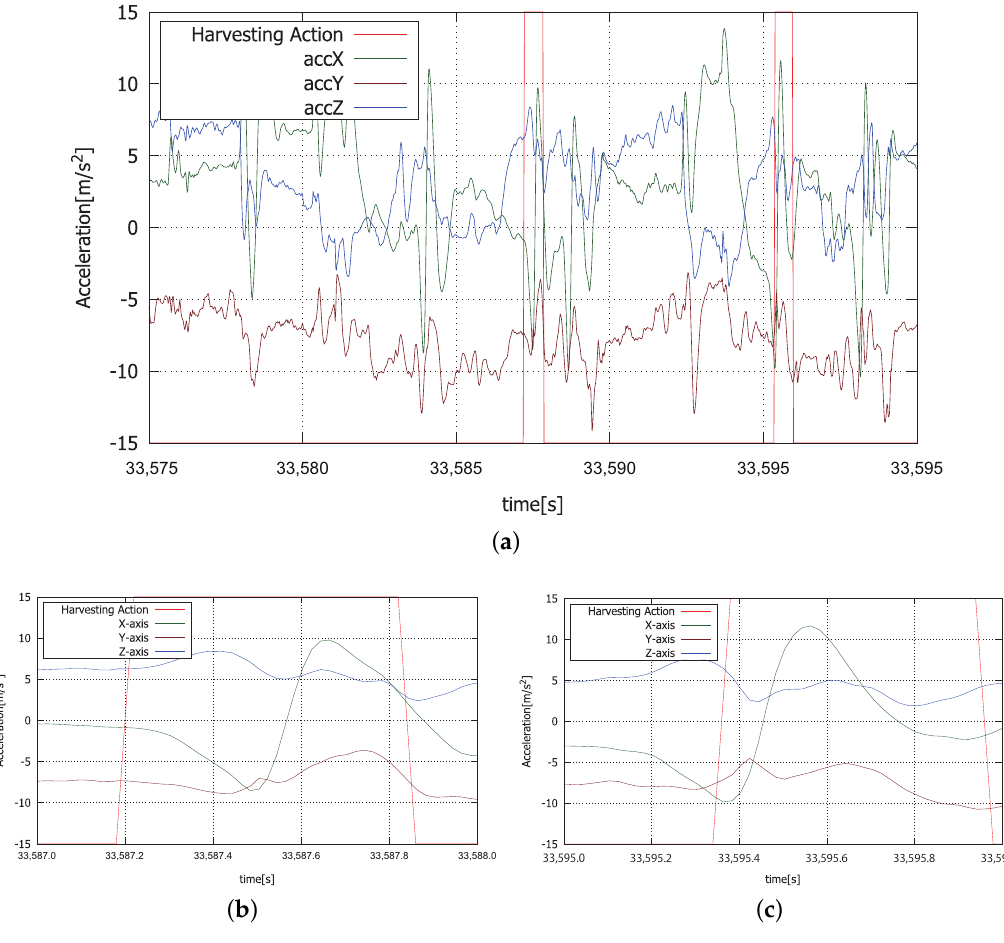
Figure 7. Two examples of acceleration sequence of harvesting action. ( a ) Two examples of harvesting action indicated between red lines; ( b ) enlargement of the first harvesting action in ( a ); ( c ) enlargement of the second harvesting action in ( a